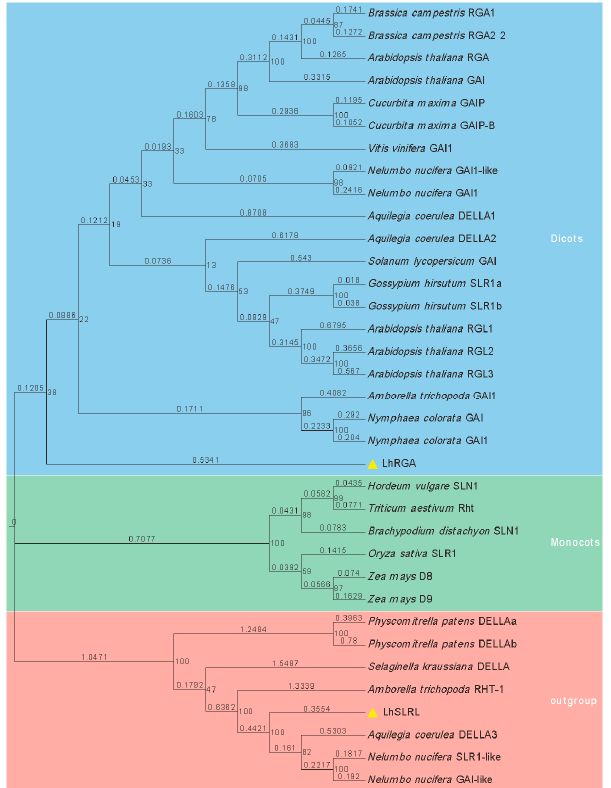
Figure 1. Phylogenetic tree of DELLA proteins from different plant species. Phylogenetic tree showing the predicted relationships between LhDELLAs and DELLA proteins of other species. Bootstrap support values are given at the nodes. This analysis involved 35 amino acid sequences. Evolutionary analyses were conducted in MEGA X.